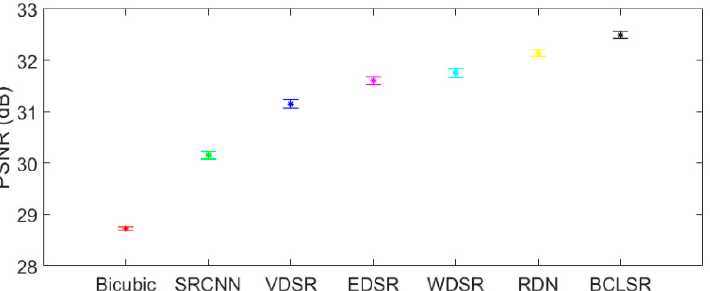
Figure 13. The mean and standard deviation of PSNR on COWC datasets at the scale factor ×4.